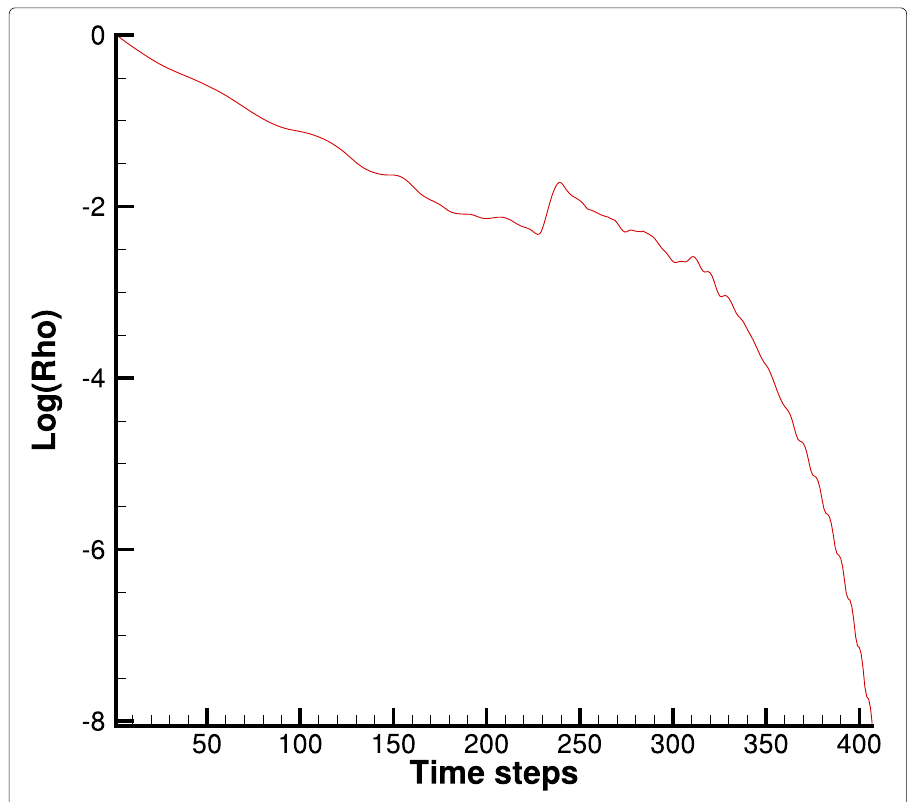
Fig. 12 Residual convergence history of the transonic flow over M6